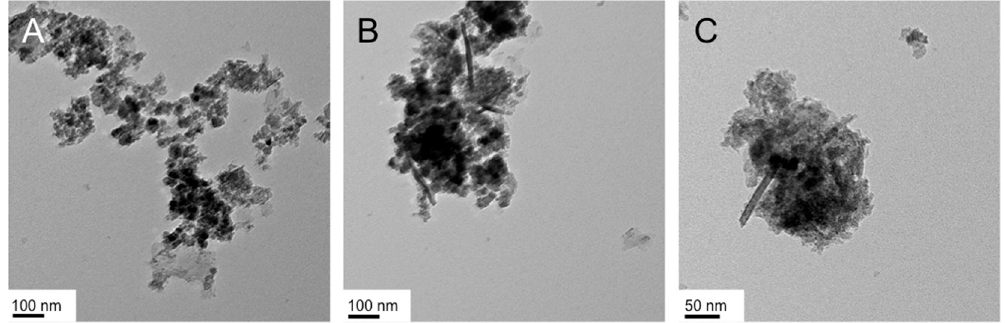
Figure 6. TEM images of the IO nanostructures obtained from the synthesis in the L α phase formed by Brij-C10 (55 wt %) in water at 85 °C: ( A , B ) froth fraction and ( C ) gel fraction.